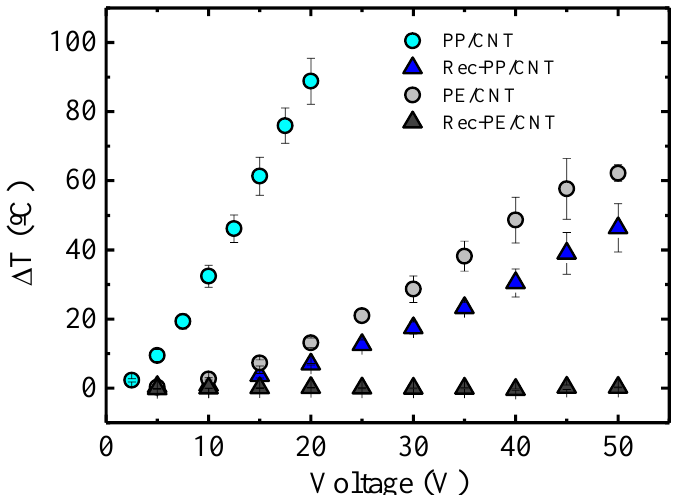
Figure6. Increase of the temperature as a function of the applied voltage for the di ff erent Figure 6. Increase of the temperature as a function of the applied voltage for the different nanocomposites.